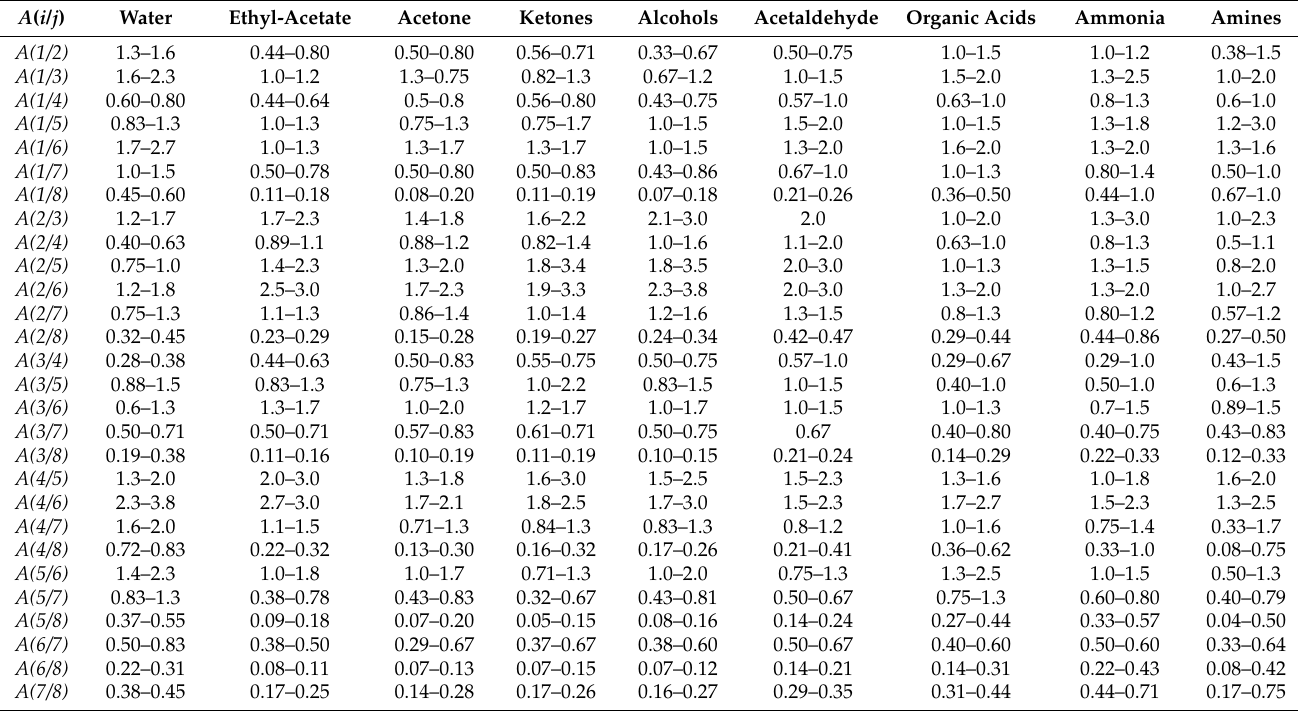
Table 3. Reference values of sorption efficiency parameters A(i/j) for different classes of volatile substances in the concentra- tion ranges indicated in Table